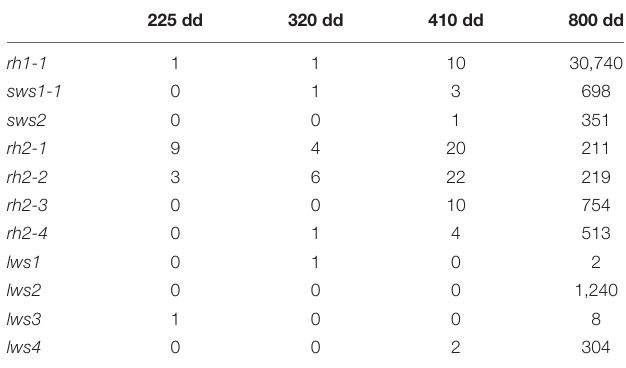
TABLE 3 | The mean of normalized counts showing the expression of visual opsins in Atlantic salmon in a developmental